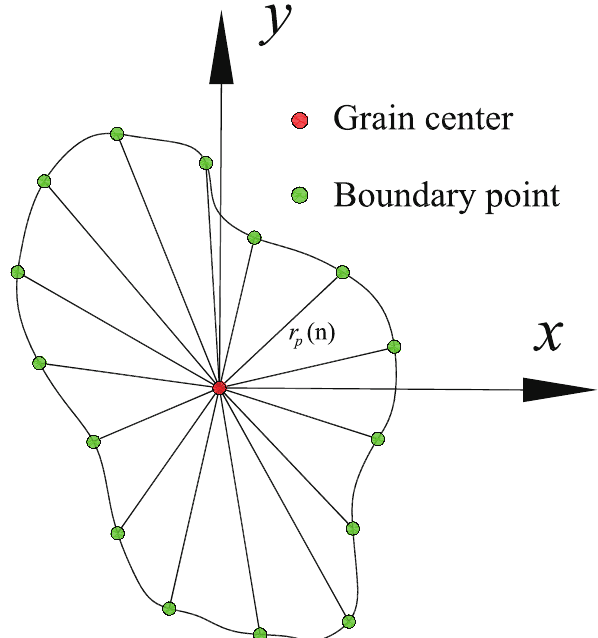
Figure 1. The plane calculation model of the